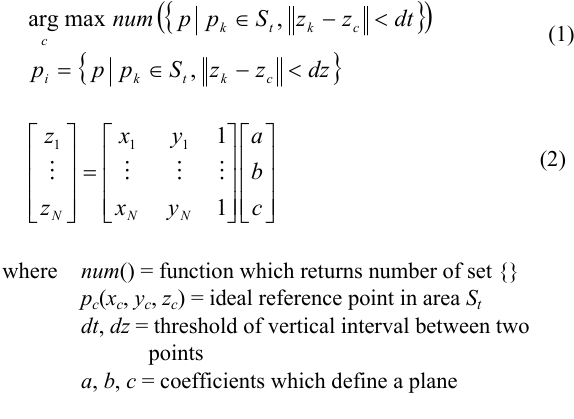
Table 1. Main specification of “MMS-X640”